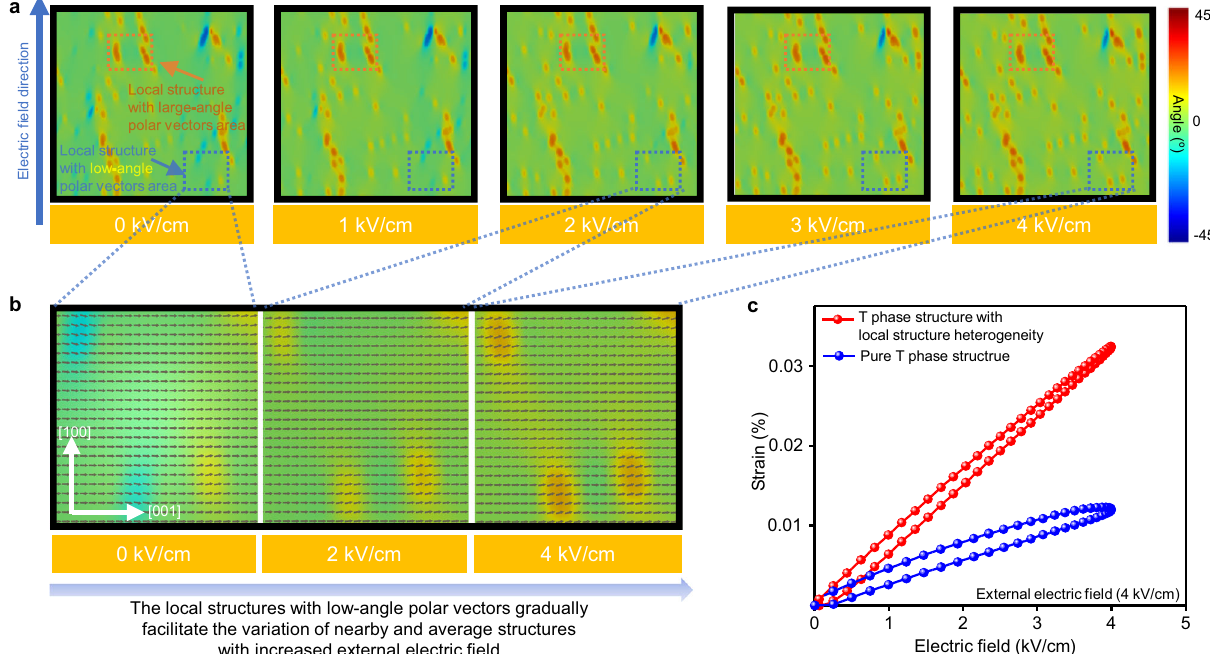
The local structures with low-angle polar vectors gradually facilitate the variation of nearby and average structures with increased external electric field Fig. 4 Phase- fi eld simulation results of mesoscale microstructure and piezoelectric strain. a Microstructural evolution as a function of applied electric fi eld along the [100] direction for the average T phase with local structure heterogeneities. The colour bar shows the angle of the polar vector direction off the [001] direction. Here, the green colour regions (angle is 0°) show the polar vector direction is along the [001] spontaneous polarization direction of the T phase. The regions with other colours show the polar vector directions are gradually deviated from the [001] direction. The local structures with large- angle polar vectors are marked with an orange frame. b The enlarged areas of the local structures with low-angle polar vectors in ( a ). The black arrows show the polar vectors. c The simulated piezoelectric strain under the electric fi eld at 4 kV/cm for tetragonal phase with and without local structure